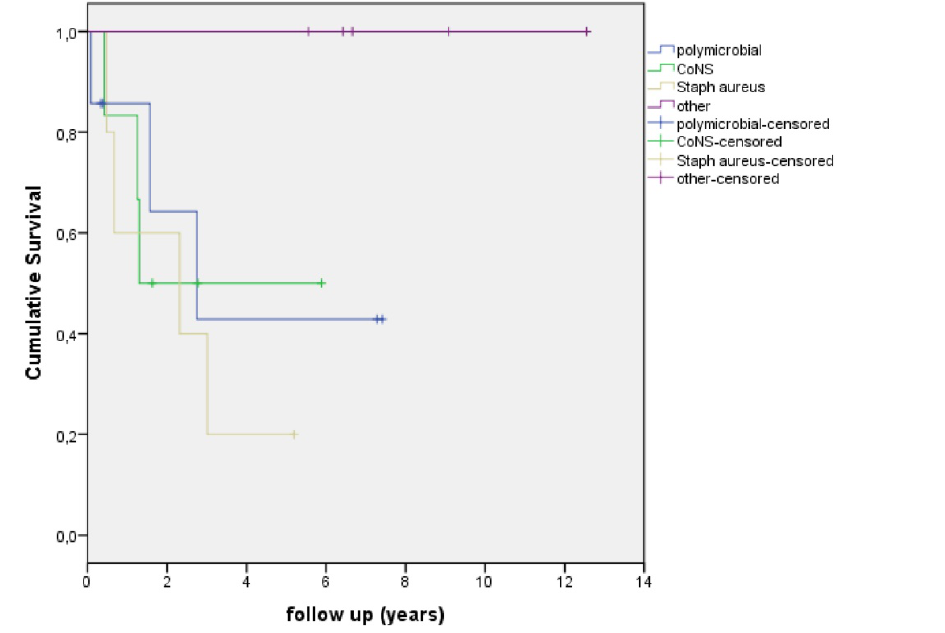
Figure 2. Kaplan-Meier curve showing survival/time without an event with different causative